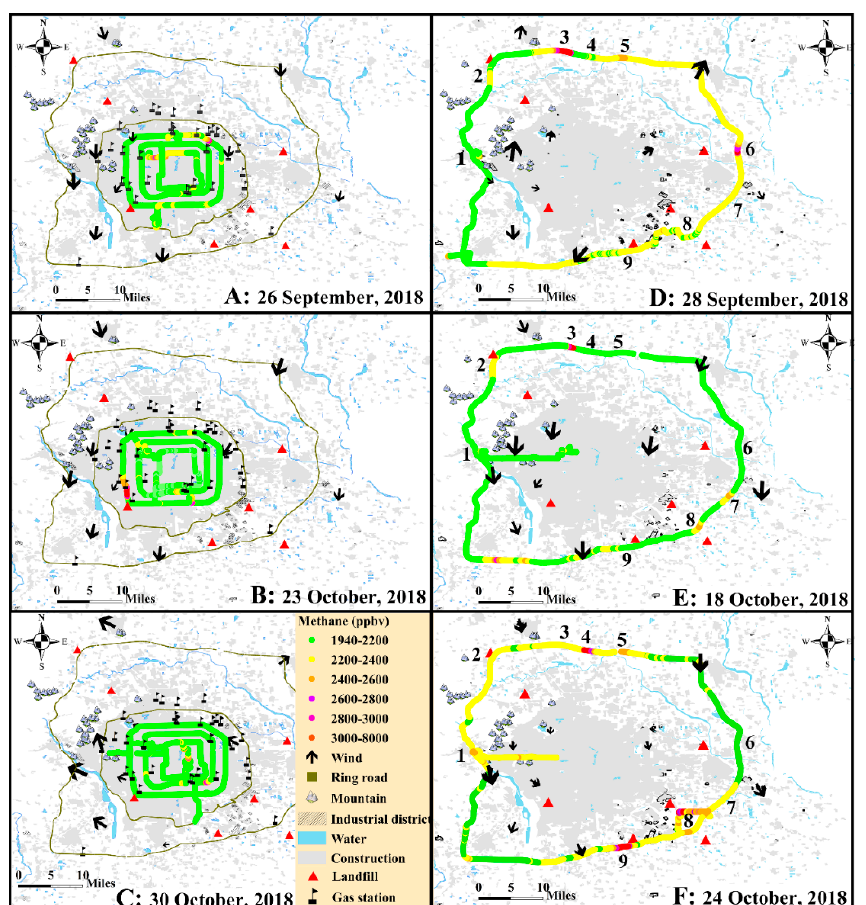
Figure 3. CH4 concentration maps of the 2nd–4th and the 6th ring roads as a function of location in non-wintertime. Note: The directions and magnitudes of arrows show the wind directions and speeds when the meteorological station was at these locations. Table 2. Statistics analysis for CH 4 concentration data of the urban and rural area.